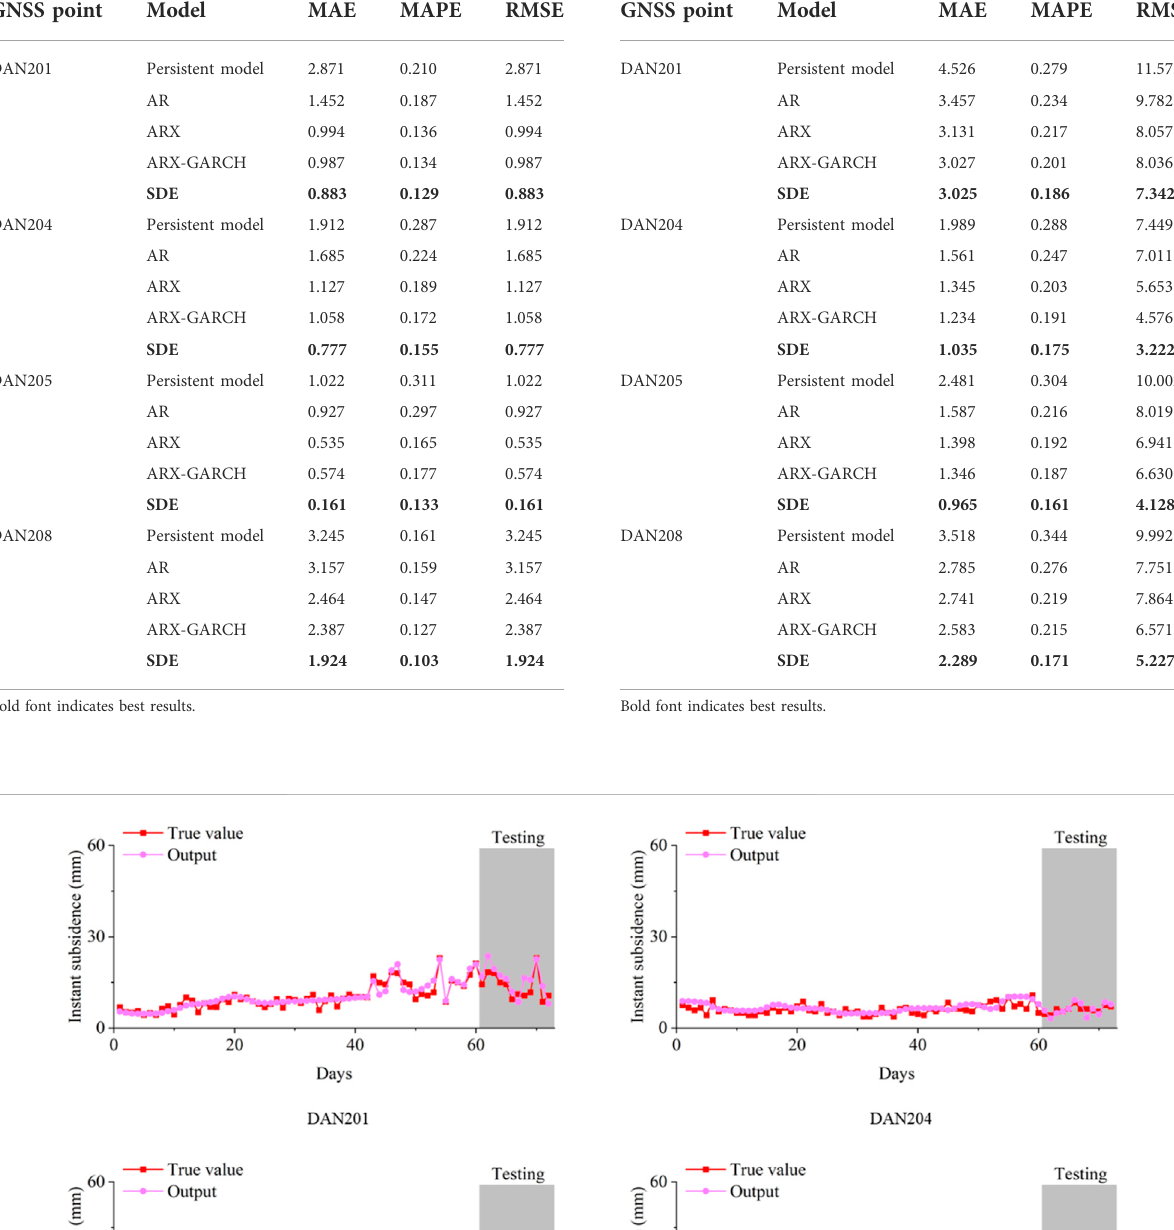
TABLE 3 Summary of 1-day ahead prediction performance.